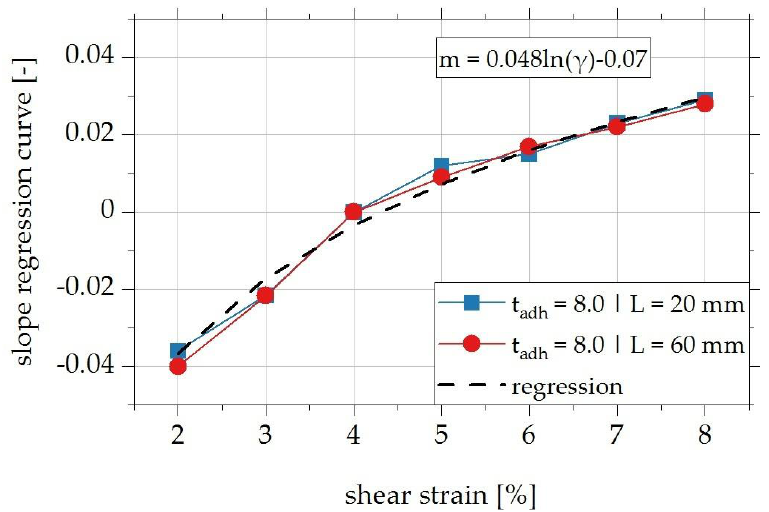
Figure 16. Slope of the regression curve to describe the influence of the test frequency on the damping properties of overlap joints adhesively bonded with the adhesive EPH as a function of the shear strain level; approximation of the experimental data by a logarithmic regression function [22].